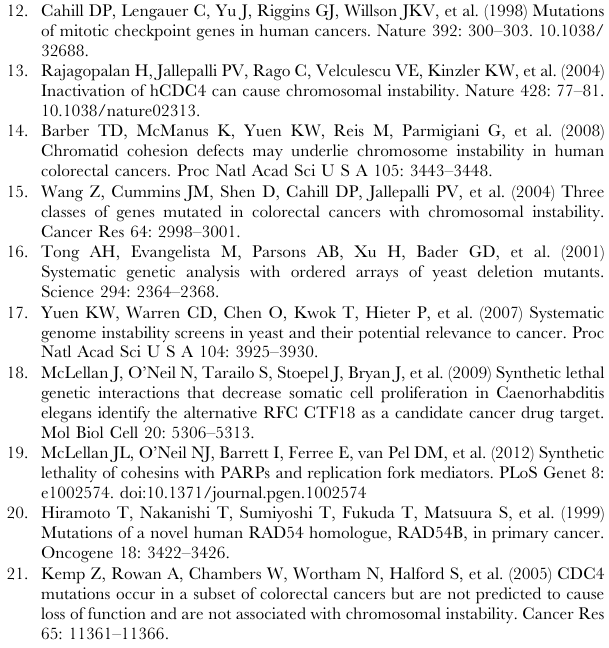
Table S1 siRNA pool silencing in HCT116 cells. Horizontal lines indicate experiments carried out on different days.